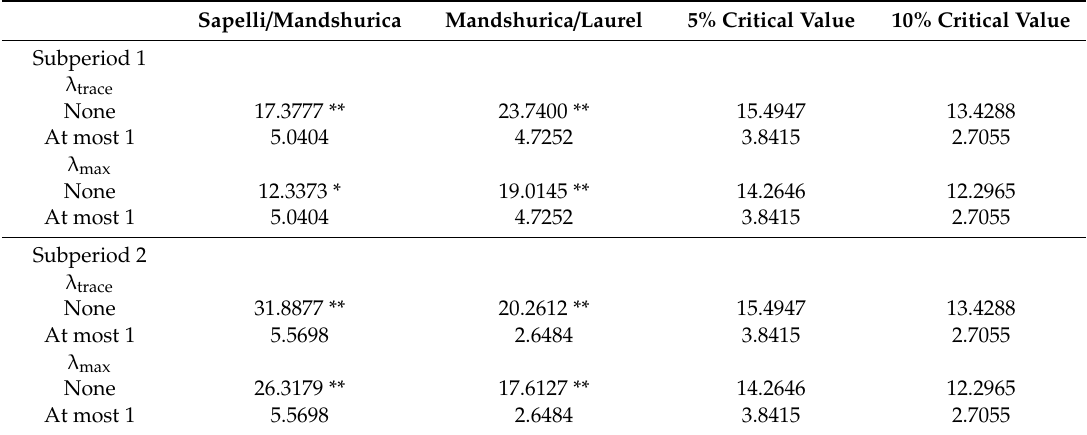
Table 3. Results of Johansen co-integration test of pairwise logarithmic